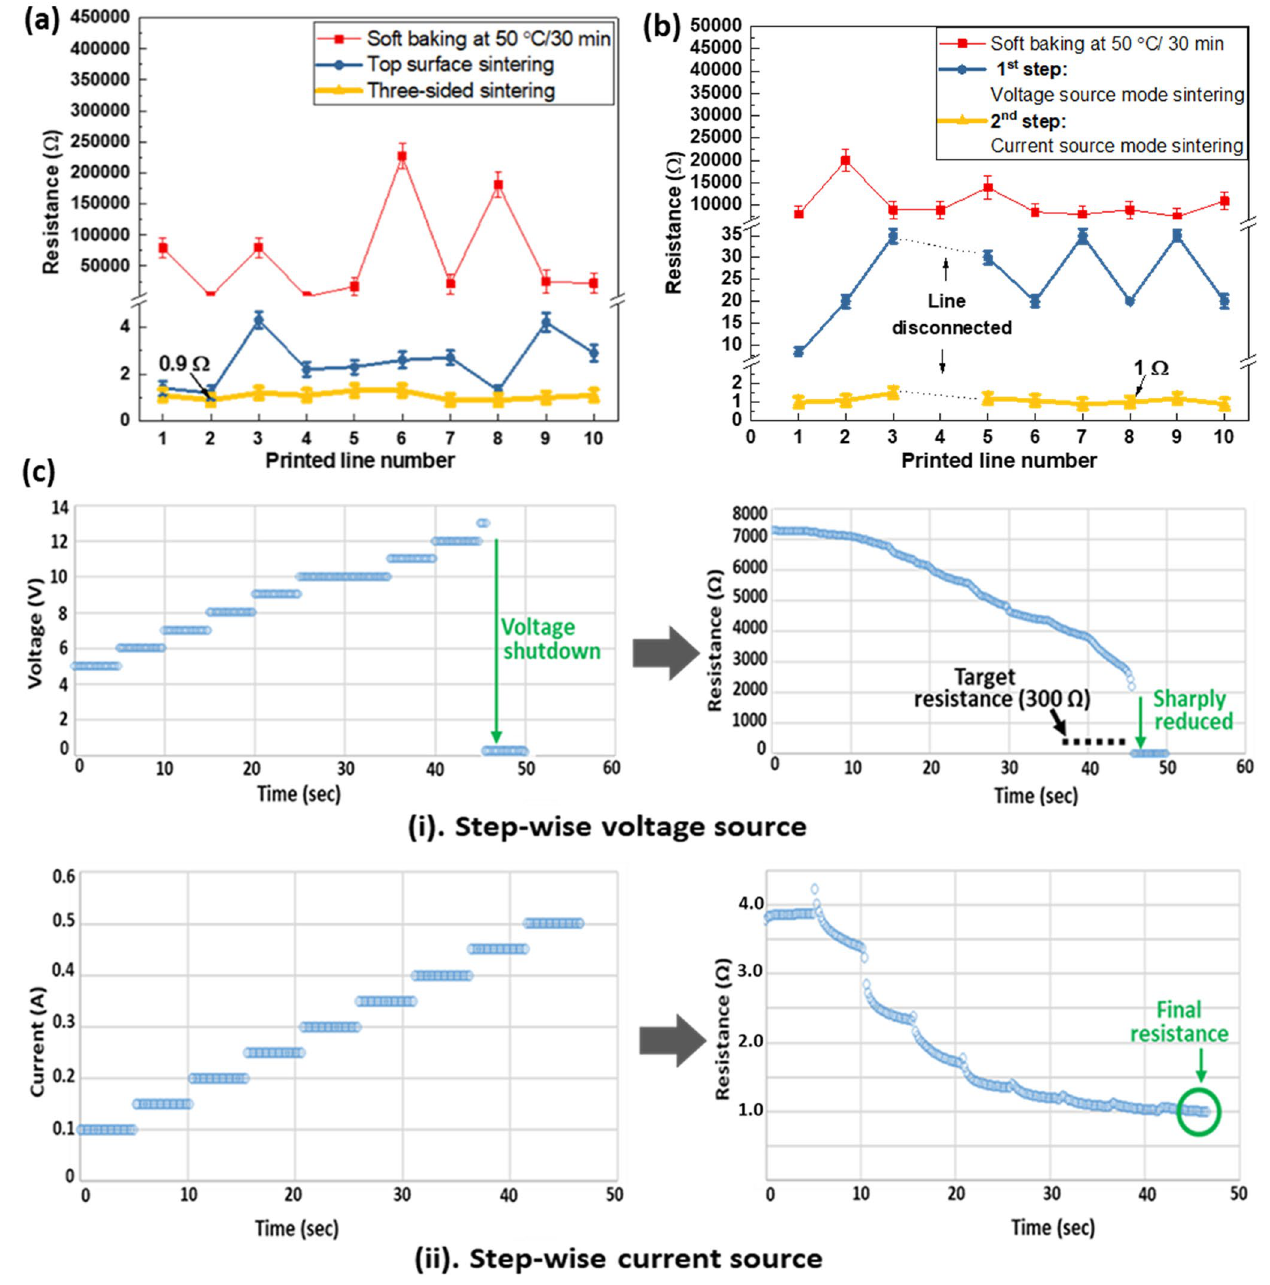
Figure 8. Localized sintering results. ( a ) NIR laser sintering results. ( b ) Electrical sintering results. ( c ) Electrical sintering